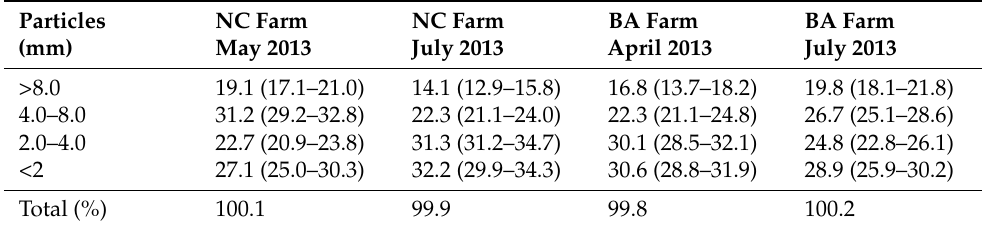
Table 7. Average of particle size distribution of the diets of the feedlots for sire production. Values expressed in